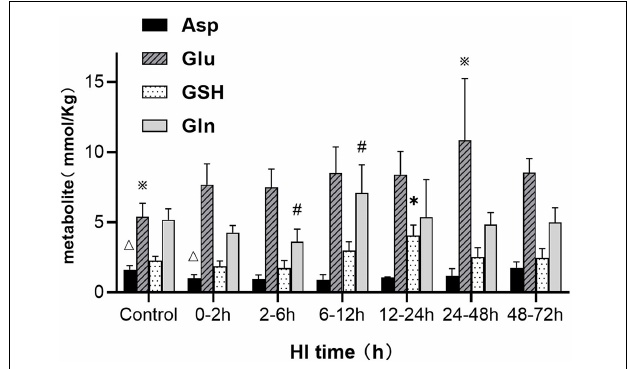
FIGURE 2 | Changes in Asp, Glu, Gln, and GSH after HI injury ( (cid:52) , , ∗ , # indicate a significant difference in a pairwise comparison, P < 0.05). The data are expressed as mean ±